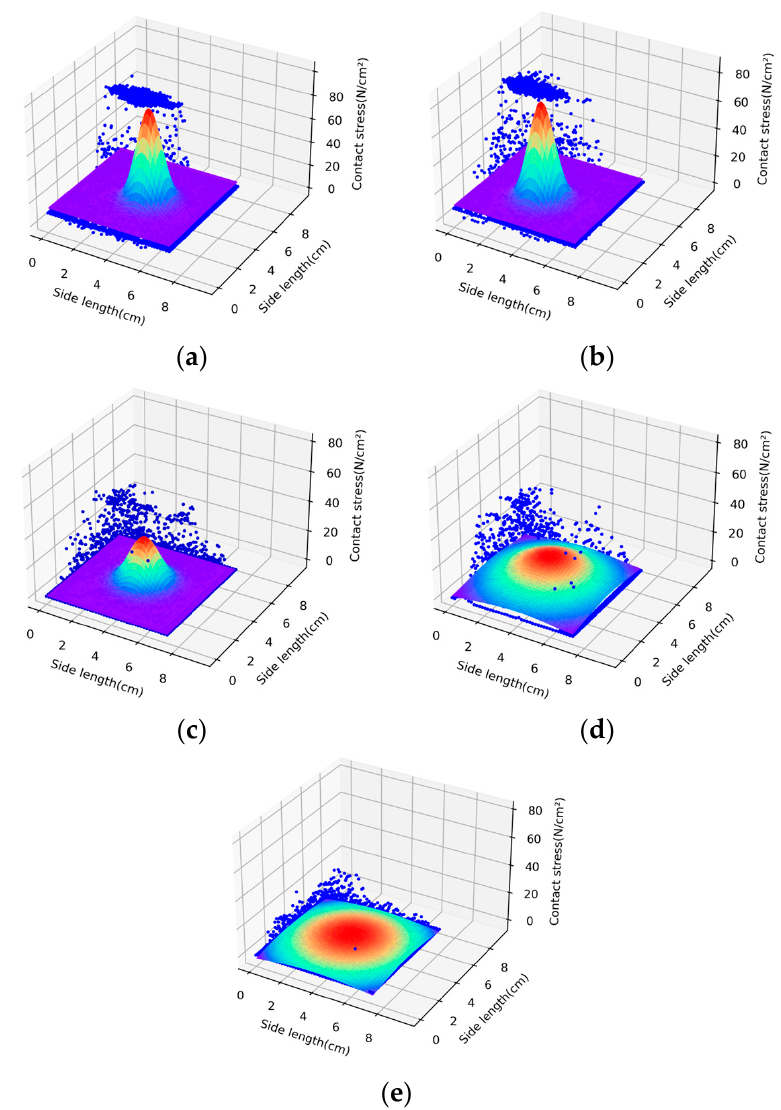
Figure 9. Comparison of 3D results of glass sheet with different aspect ratios under concentrated load: ( a ) aspect ratio of 18.75; ( b ) aspect ratio of 15; ( c ) aspect ratio of 9.375; ( d ) aspect ratio of 7.5; and ( e ) aspect ratio of 6.25.